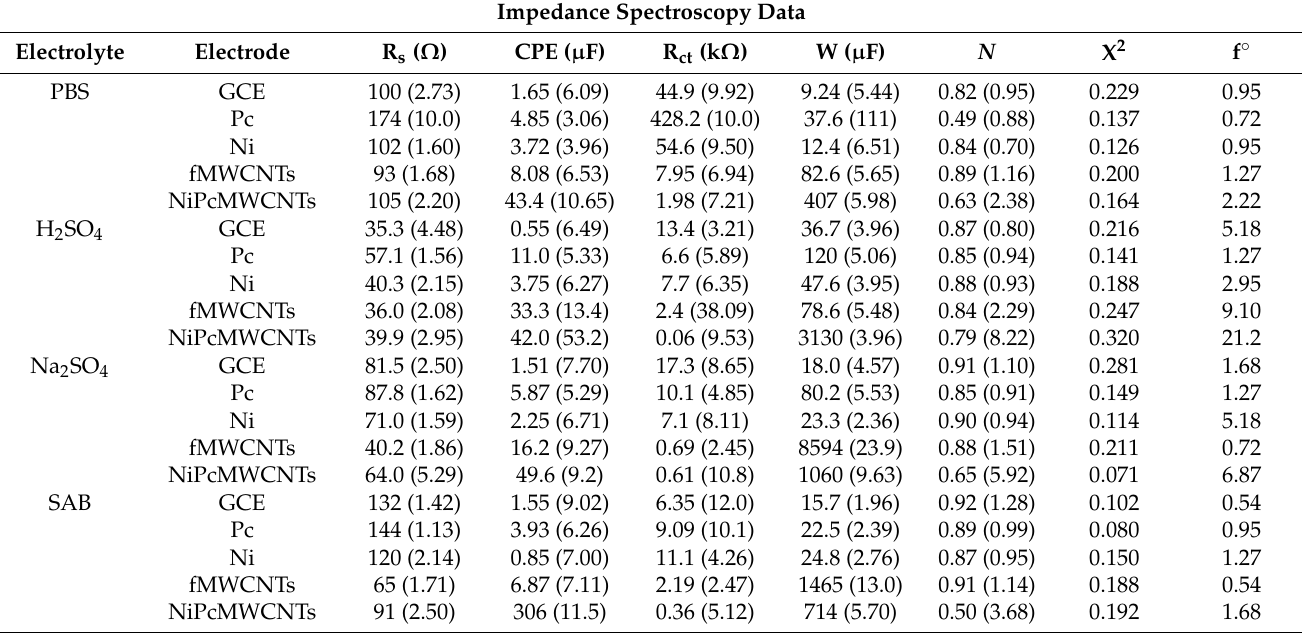
Table 2. Summary of fitted EIS results of bare and modified electrodes in different electrolytes. Impedance Spectroscopy